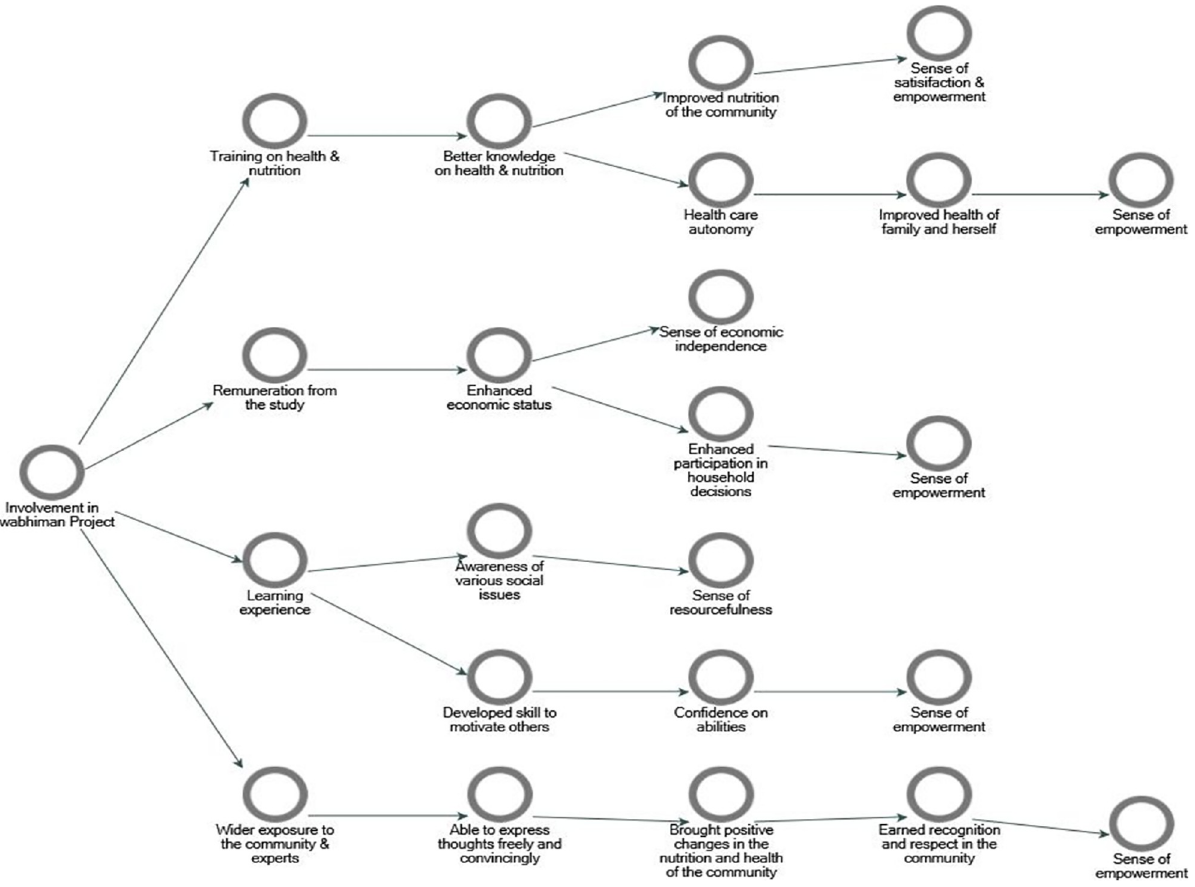
Fig 5. Mind map of women empowerment through involvement in the